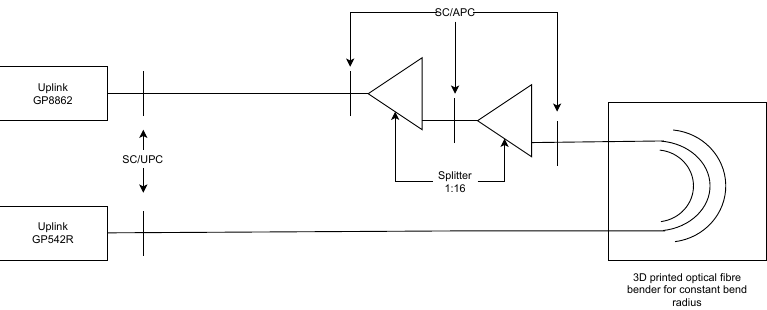
Figure 7. Scheme of attenuation measurement using the OLT unit.